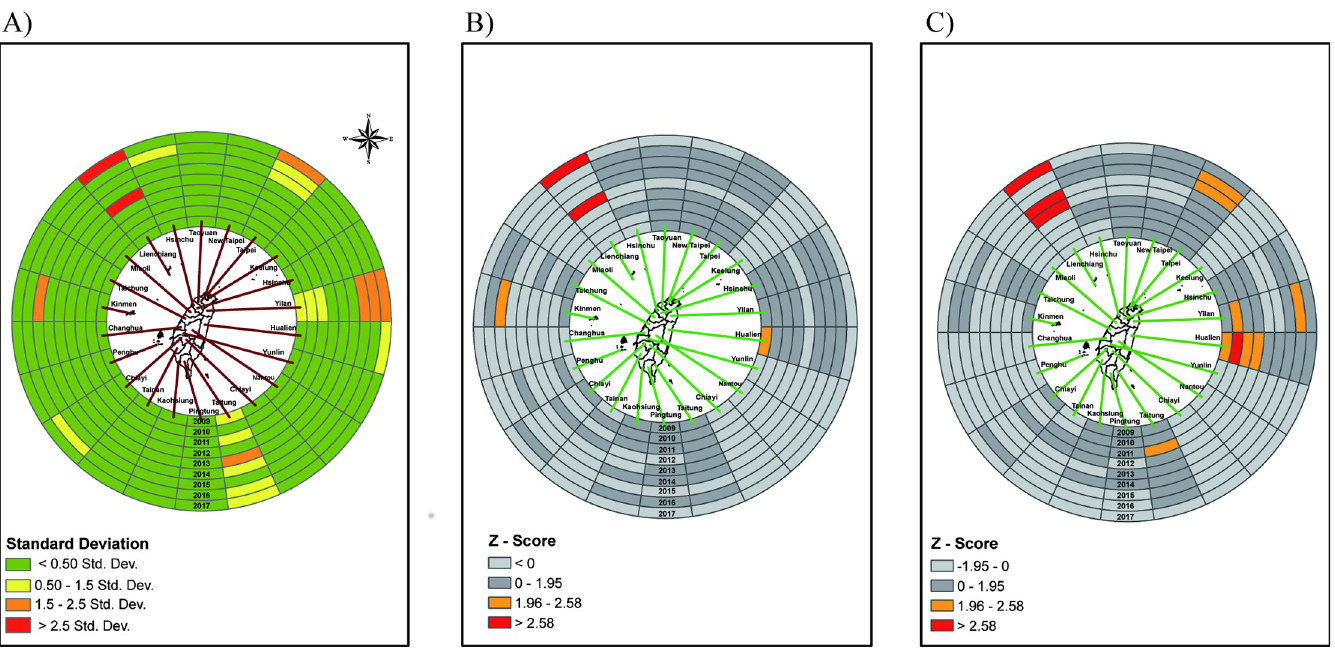
Fig 2. Ring map of outpatient visit rate of scarlet fever in age group 3–4 years. (A) A Z score ring map from innermost in 2009 to outermost in 2017. (B) A ring map of Z-scores by applying spatio-temporal G i � without time lag. (C) A ring map of Z-scores by applying spatial-temporal G i � with 1 year lag.